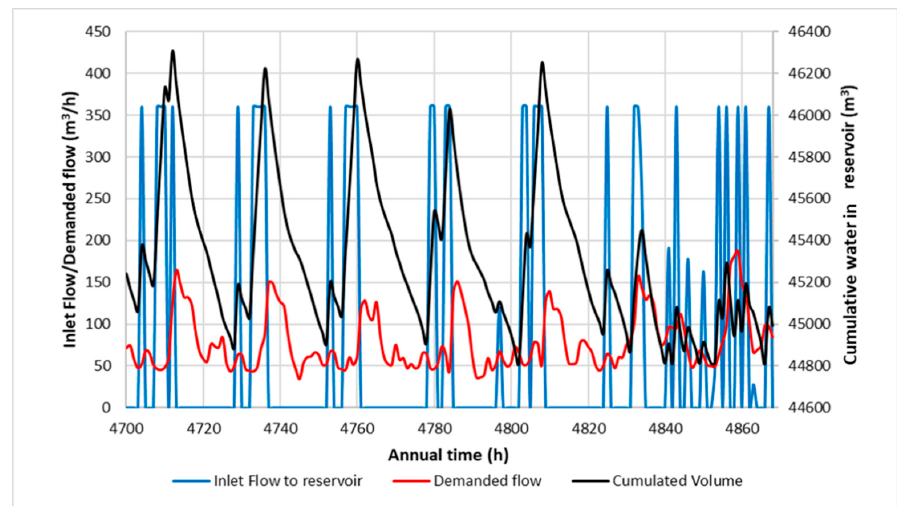
Figure 4. Example of demanded sources in the third week of June by applying Selim and Figure Ozkarahan’s approach.